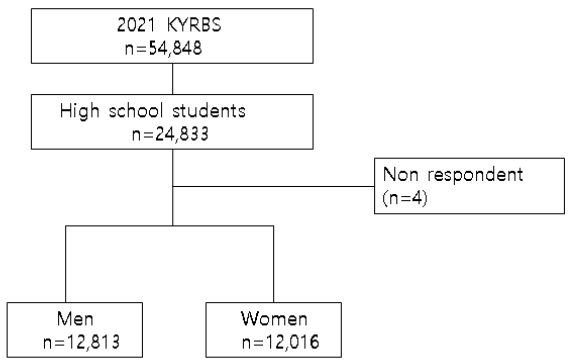
Figure 1. Subject Figure 1. Subject selection.